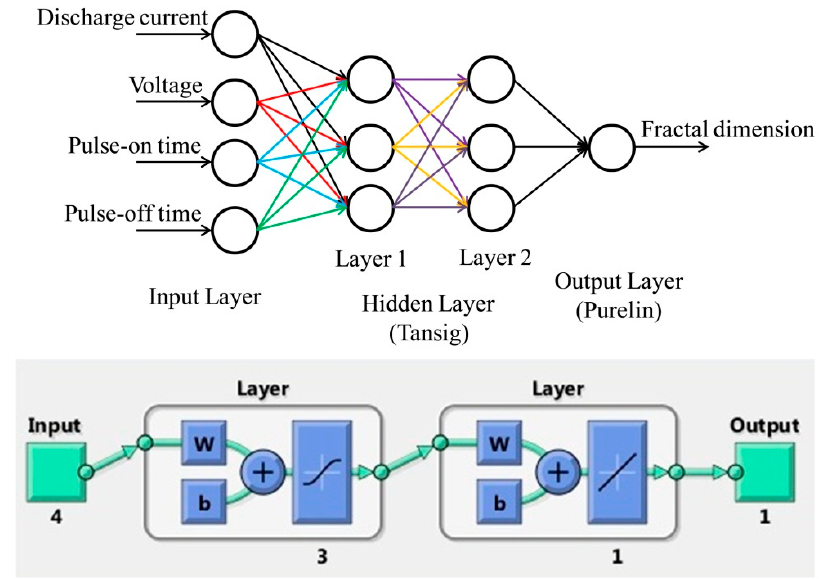
Figure 2. A 4-3-3-1 artificial neural network (ANN) architecture for the prediction of the fractal dimension.